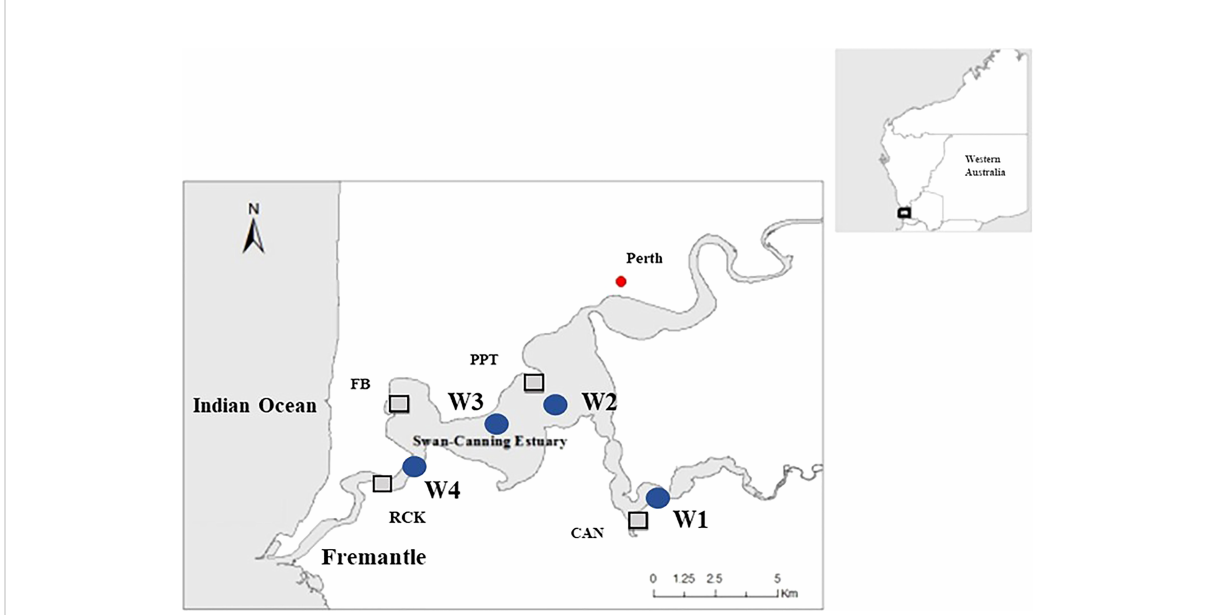
FIGURE 1 Study sites (box) and the water quality monitoring (circle) across the Swan-Canning estuary (Webster et al., 2021). FB and RCK located at downstream, and PPT and CAN located at